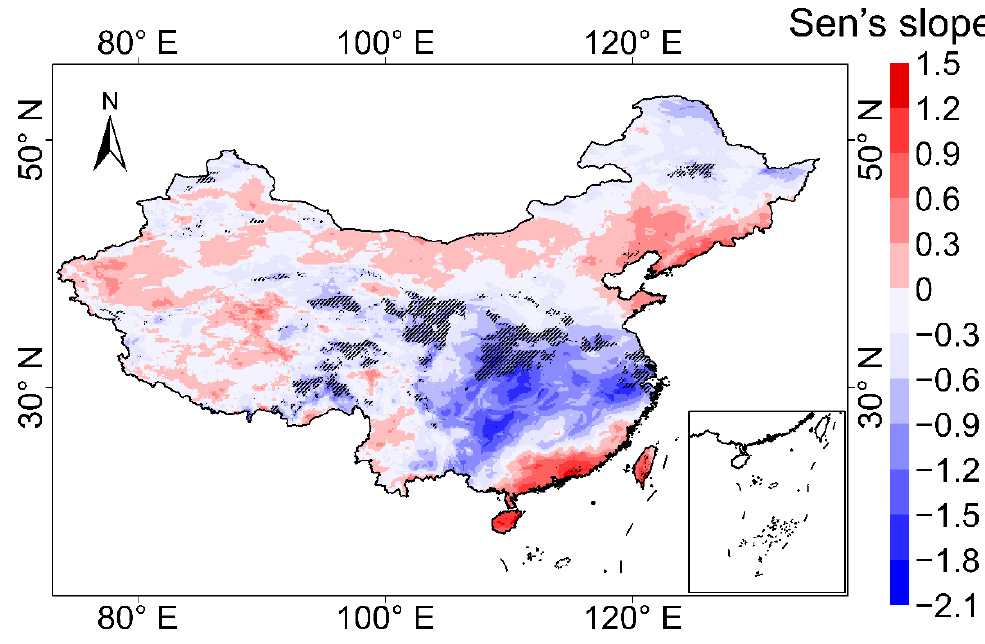
Figure 6. POAI trends in China from 2010 to 2020. The shaded part is where the Mann–Kendal trend test passed the 90% significance test.